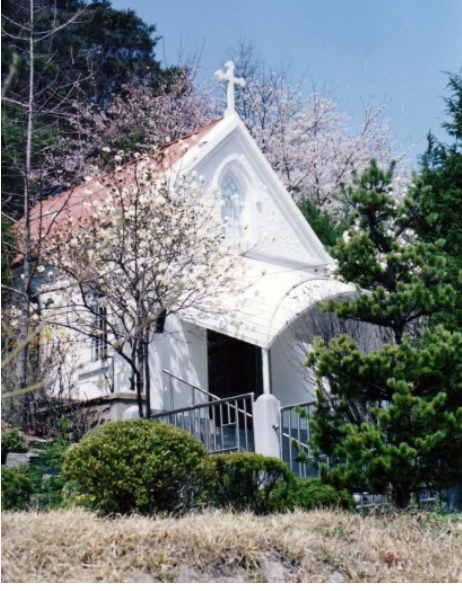
Religions 2021 , 12 , x FOR PEER REVIEW Figure 10. Image dated 26 September 1976 [source: courtesy of Mirinae Church]. Figure 10. Image dated 26 September 1976 [source: courtesy of Mirinae Church].